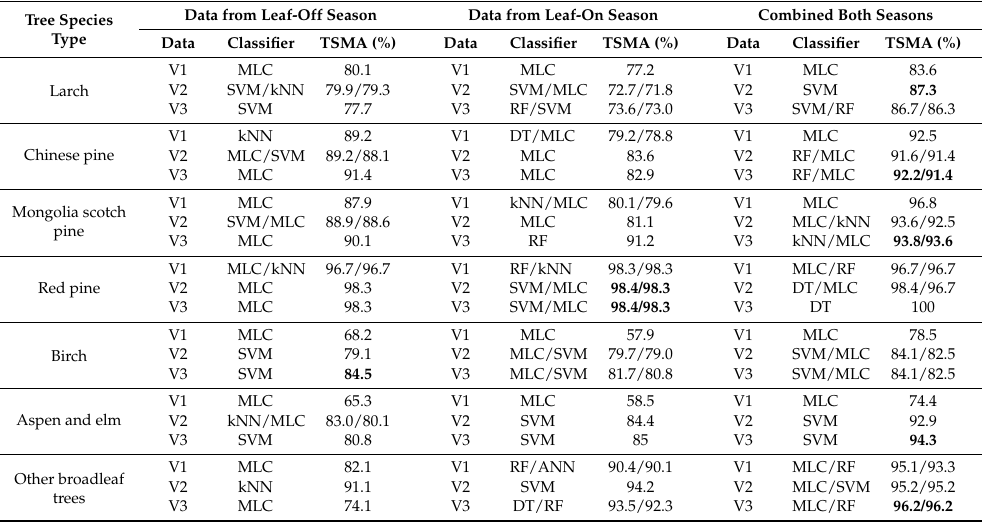
Table 10. Summary of the best classification accuracy for each tree species based on different classification algorithms and different data